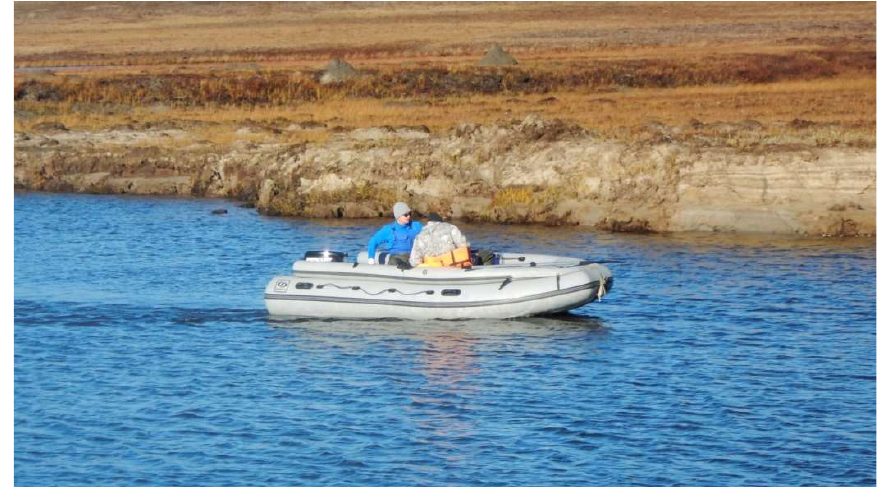
Figure 5. Echo sounding and ground penetrating radar survey (GPR) on the water area of the Seyakha C11 Crater from the motor boat “Fregat”, 19 September 2018 (photo by Roman Nikonov). 3.4. Creating 3D Models of the Water Area Bottom, Adjacent Area Elevation and Structure of the Upper Part of Sedimentary Cover